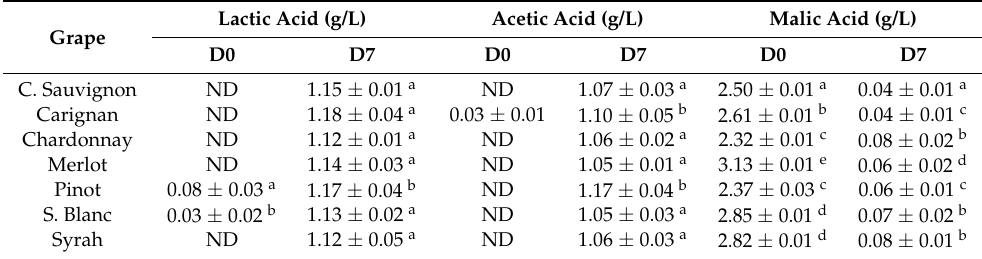
Table 4. Organic acids produced after 7 days of spontaneous fermentation.